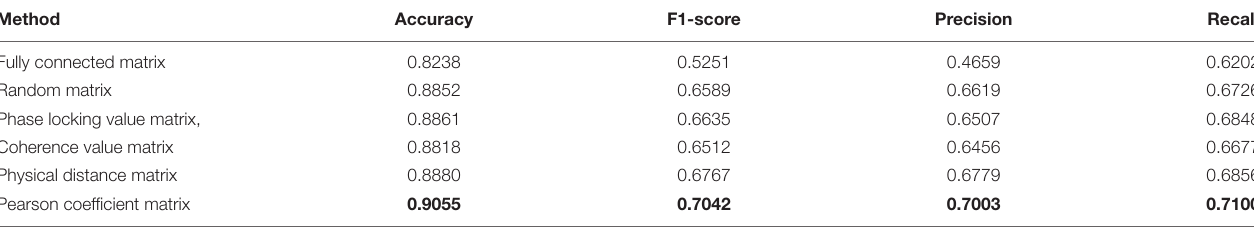
TABLE 5 | Comparison of effects of using different adjacency matrix initialization